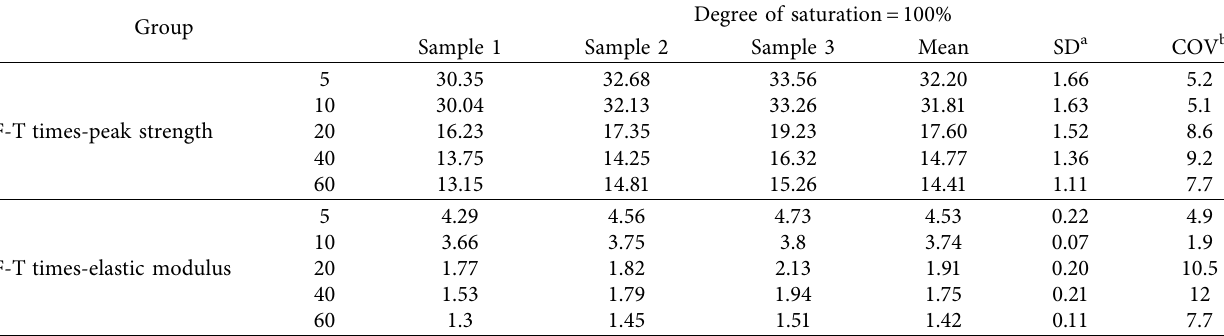
Table 2: Results of peak strength and elastic modulus.